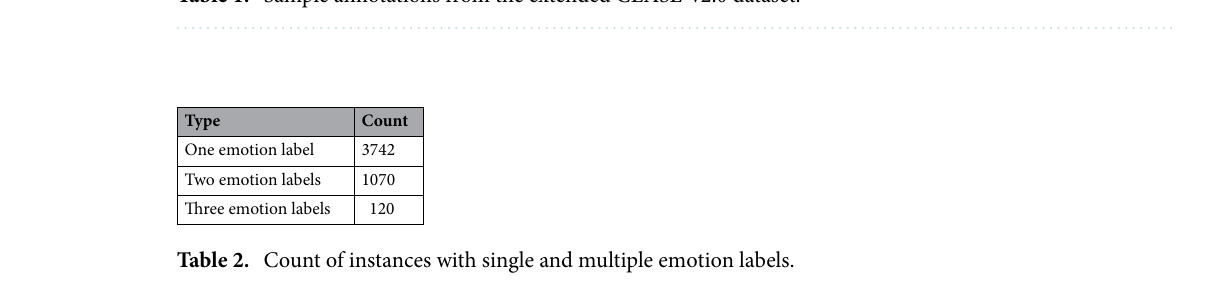
Table 1. Sample annotations from the extended CEASE-v2.0 dataset.